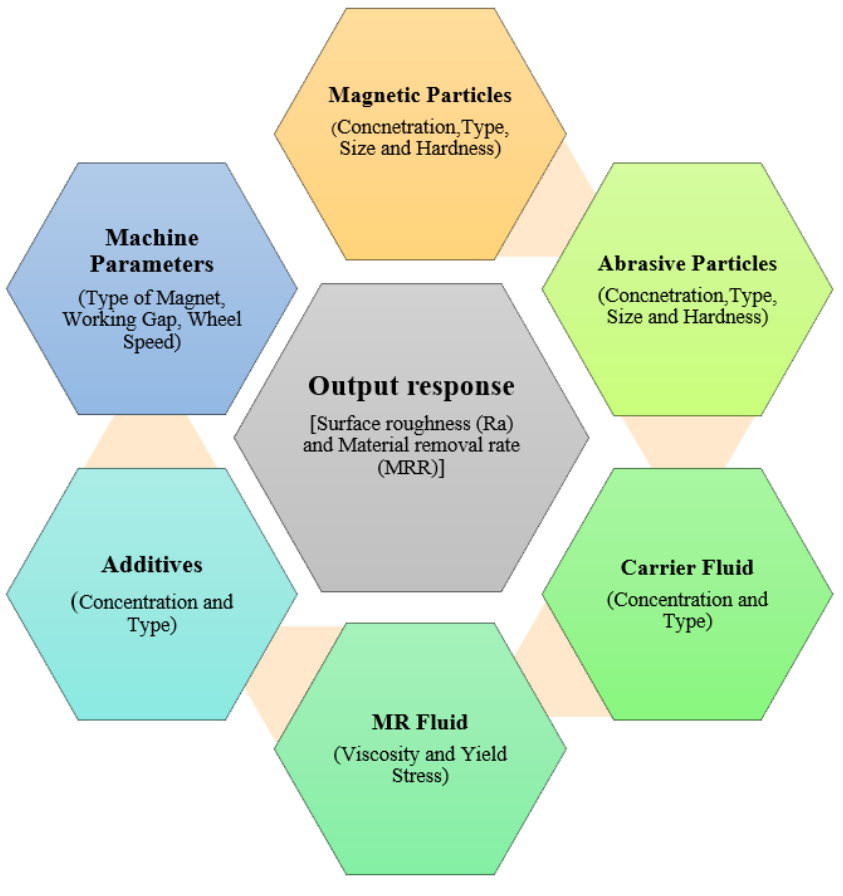
Figure 54. The parameters affect the MRF process.